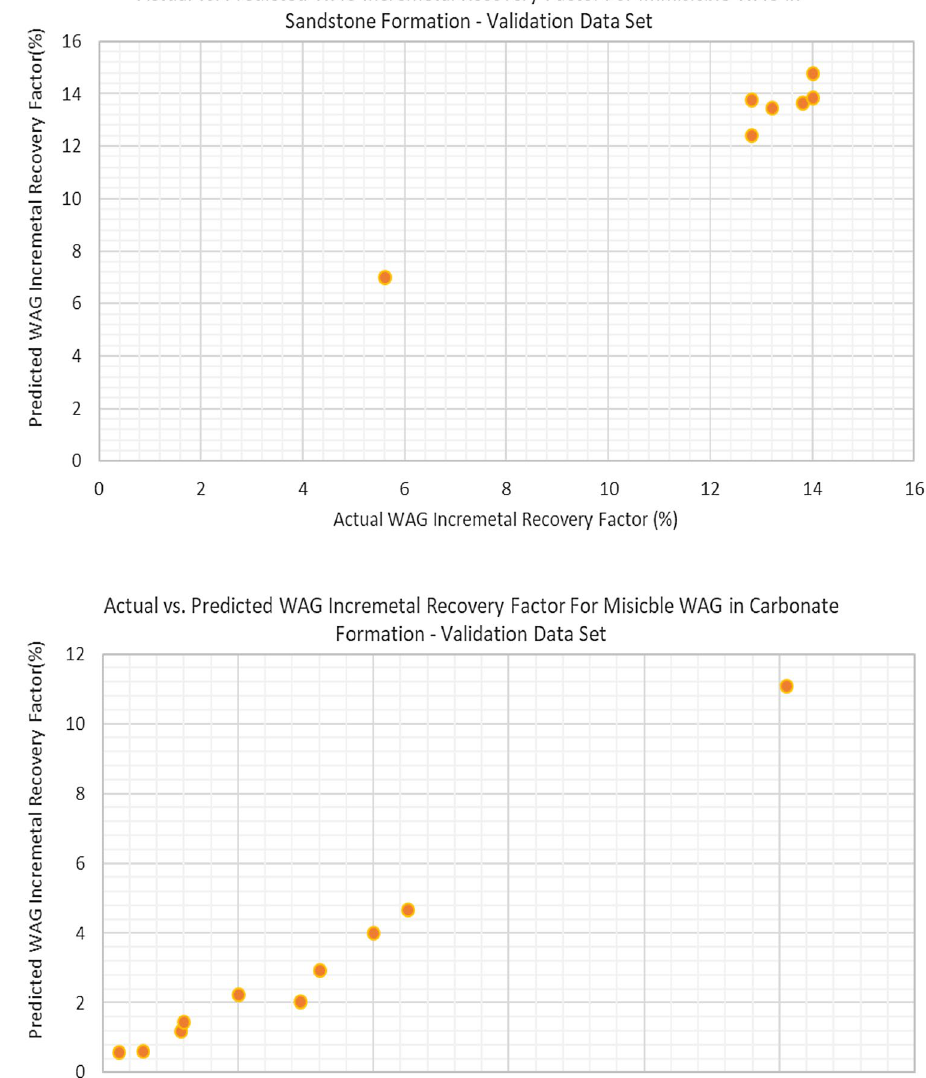
Fig. 18 GMDH WAG incre- mental recovery factor predic- tion model validation results for immiscible WAG in sandstone formation